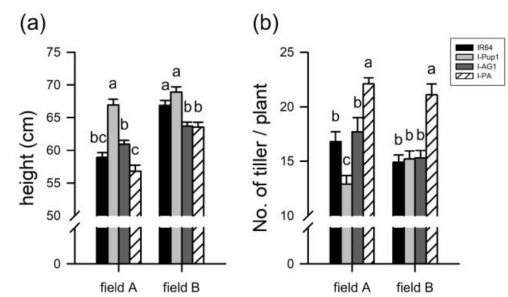
Figure 6. Height and tiller number of I-PA (IR64-Pup1-AG1) at 60 DAT (days after transplanting) in paddy fields. The height ( a ) and tiller number per plant ( b ) of I-PA and NILs at 60 DAT. Locations and conditions of the field are mentioned in Materials and Methods. The letters above bars represent statistical significance ( p < 0.01) as measured by Duncan’s multiple range